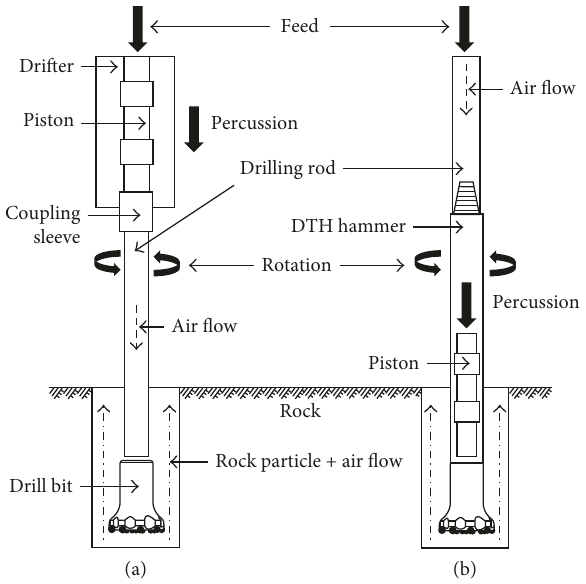
Figure 1: Drilling mechanisms of two types of percussive drilling system: (a) top-hammer drilling and (b) down-the-hole drilling (modified from Song et al.